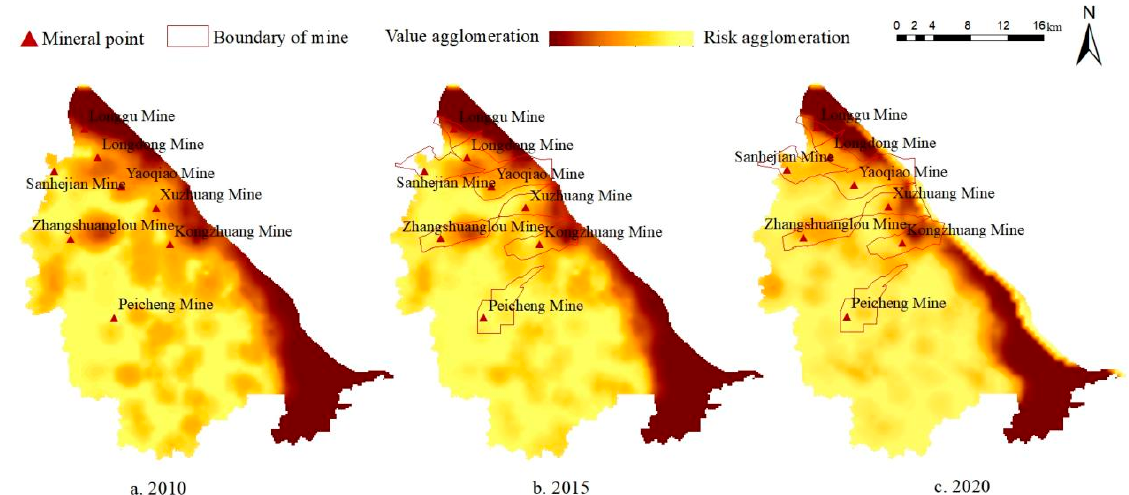
Figure 6. Spatial distribution of inconsistent index in 2010, 2015, and 2020.